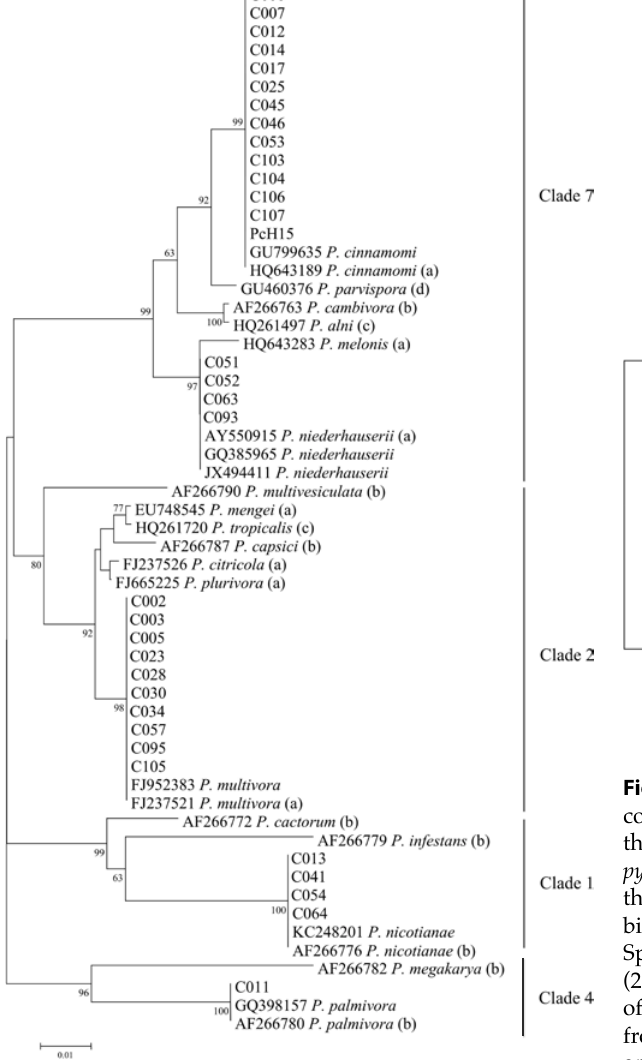
Figure 3. Phylogenetic tree constructed using the neigh- bour-joining method based on rDNA-ITS sequences that show the positions of Phytophthora isolates that were ob- tained in this study and were found to belong to clades 1, 2, 4 and 7, as defined by Cooke et al. (2000). Type isolate of the species (a); sequences used by Cooke et al. (2000) (b), Ro- bideau et al. (2011) (c), and Scanu et al. (2014) (d). Numbers at the nodes of clusters represent bootstrap values that were generated from 1,000 pseudoreplicates (only values greater than 60% are shown). (Table 1). Phylogenetic analysis with a subset of 13 out 20 of these isolates grouped them into a single highly supported clade (100% bootstrap support) that con-